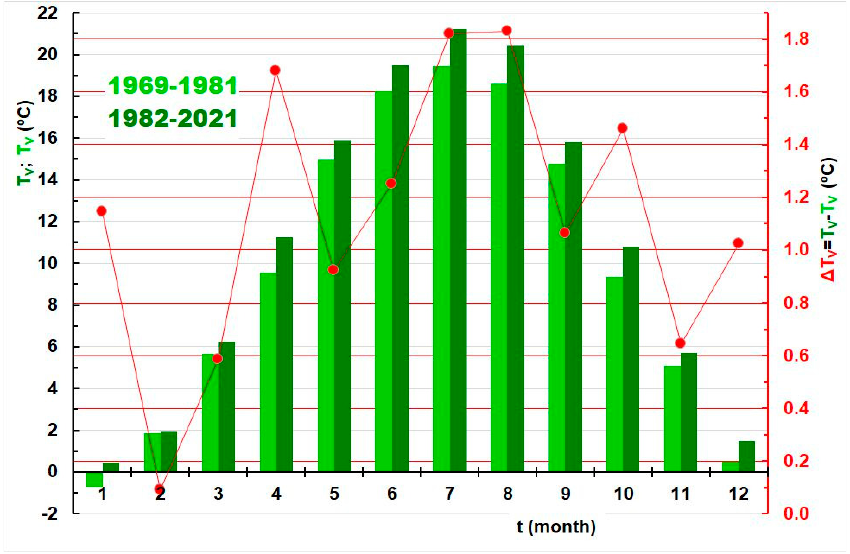
Figure 8. Histograms of average monthly air temperatures in Varaždin, T V , during the two subperi- ods: 1969–1981 (light green color) and 1982–2021 (dark green color). A line graph of their differences, Δ T V , during the two subperiods above is shown in red.